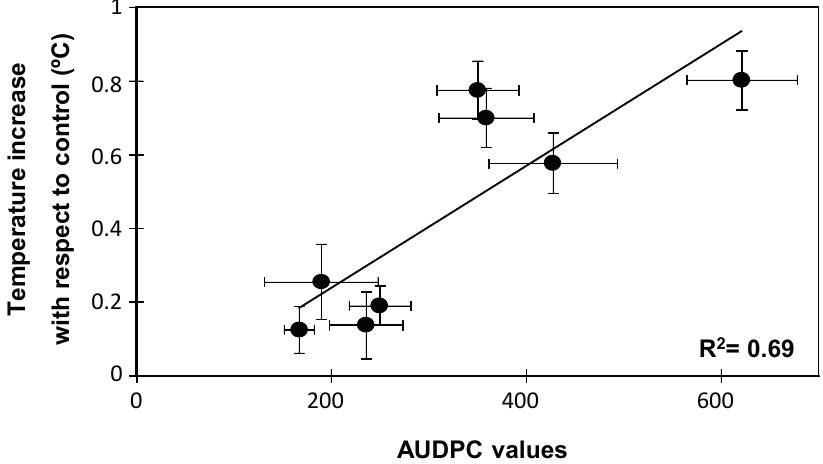
Figure 4. Relationship between the level of susceptibility to F. oxysporum f. sp. pisi ( Fop ) and surface leaf temperature. The graphic represents the linear correlation calculated for the differences in surface leaf temperature detected for each P. sativum accession between inoculated and control plants at 10 days post-inoculation with Fop in relation with their corresponding AUDPC values. Horizontal bars are standard errors for AUDPC values with n = 10 while vertical bars are standard errors for the differences in surface leaf temperature calculated with n =